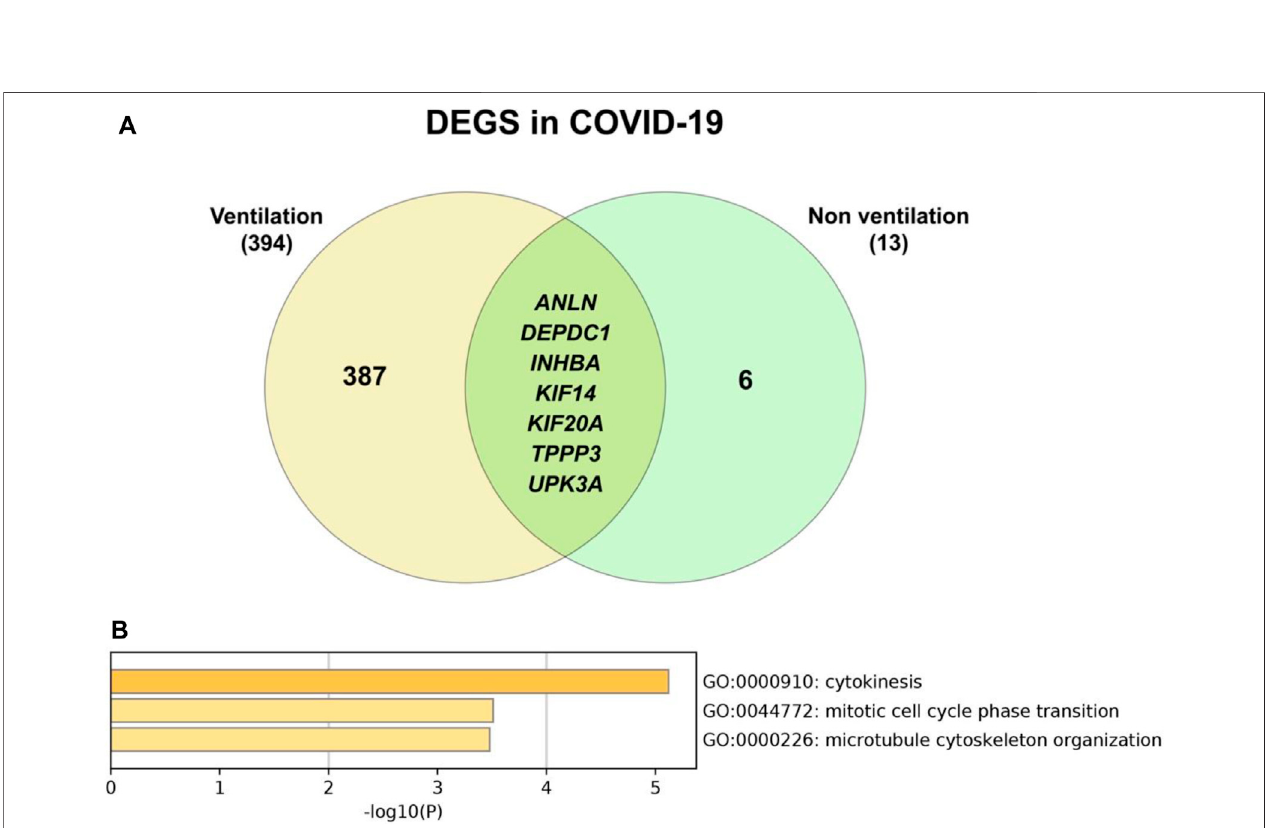
FIGURE 16 | (A) Number of genes that are common between COVID-19 patients regardless of use of ventilation or not (B) Common genes are mostly involved in GO biological processes for cell division.